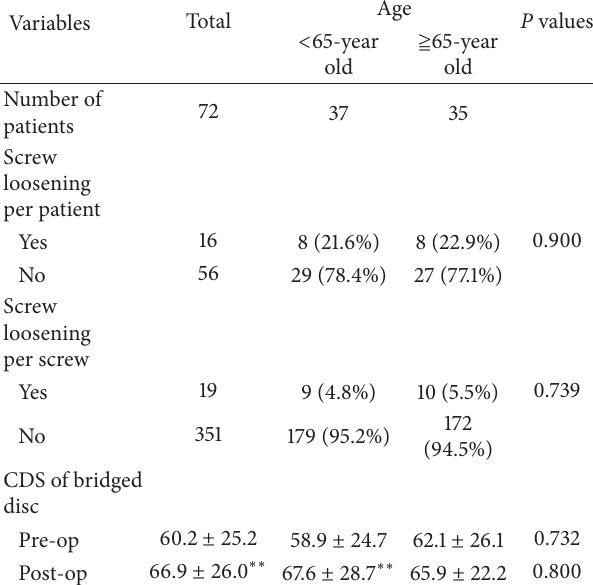
Table 4: Comparison of disc signal change between young age and old